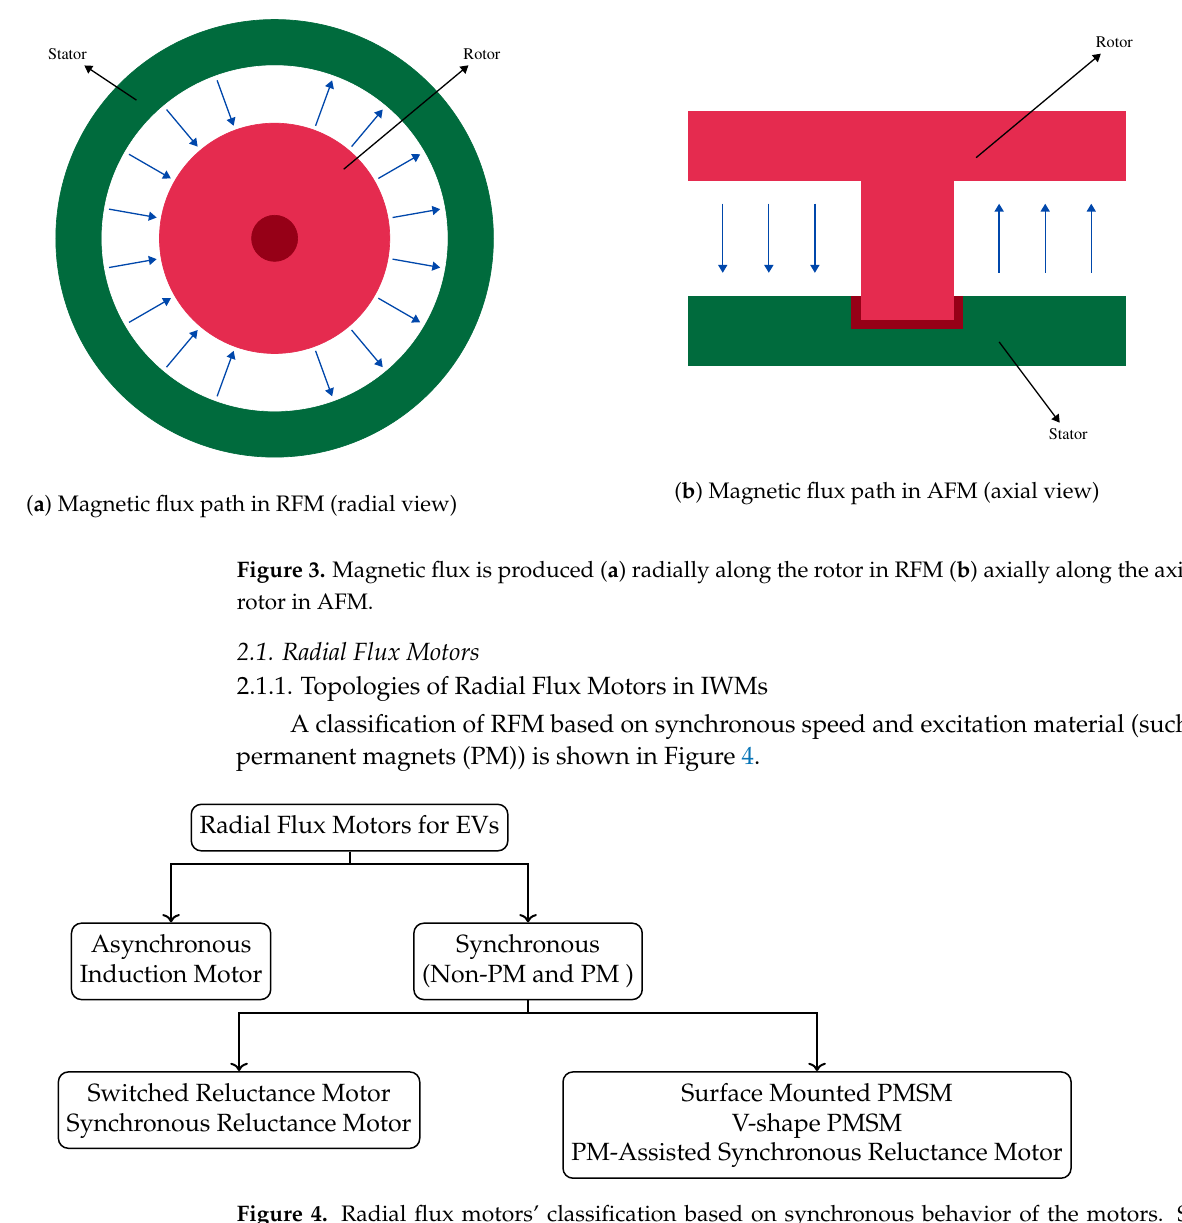
Figure 4. Radial flux motors’ classification based on synchronous behavior of the motors. Syn- chronous motors are further classified based on the usage of